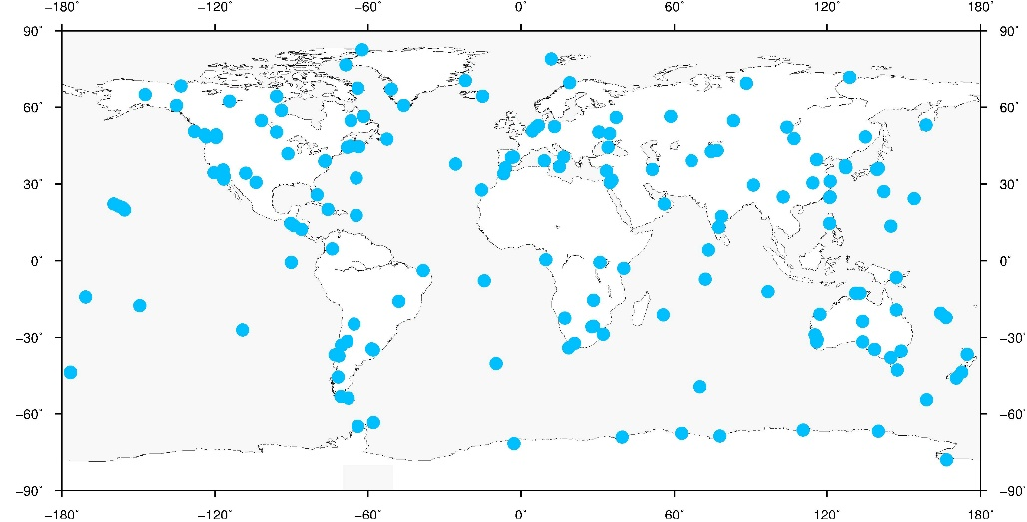
Figure 1. Spatial distribution of the selected 186global navigation satellite system(GNSS) stations.